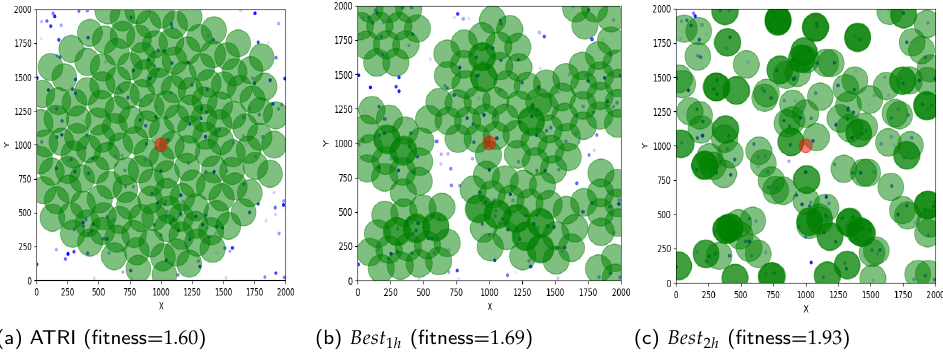
Figure 9. ( a – c ) show networks on Tr 1 using ATRI, GANet 1-hop, GANet 2-hop. GANet obtains better performance by focusing more on areas with users and avoiding areas with no